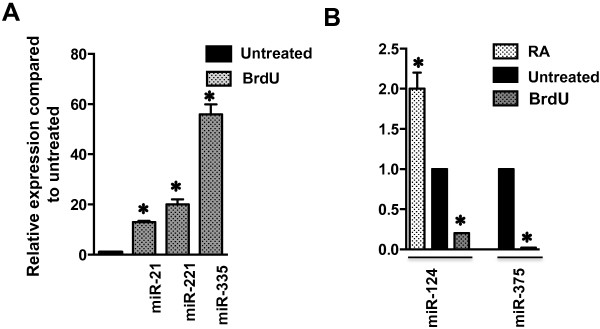
Drug-induced irreversible differentiation of I-type NB cancer stem cell confirms the association miRNAs with cell phenotype. A. Fold increases in miR-21, -221 and -335 in BE(2)-C cells differentiated to an S phenotype following a 2 week treatment with 10-5 M BrdU. B. Changes in miR-124 and -375 expression in BE(2)-C cells treated with RA or BrdU to induce an N or S phenotype, respectively. Each bar represents the mean ± SEM of 4–6 determinations normalized to untreated controls set =1.0.